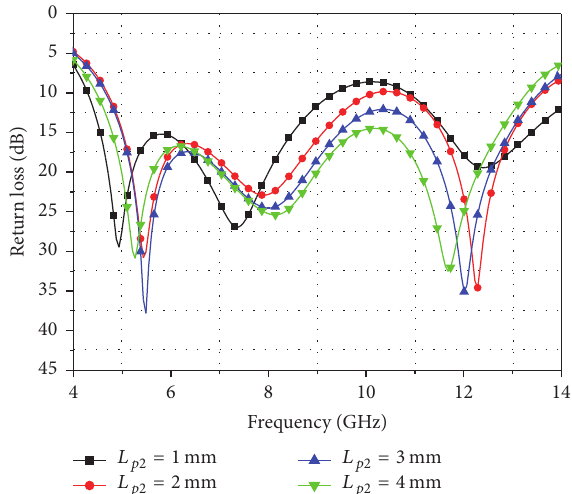
Figure 7: Simulated return loss against frequency for the proposed defectedsubstratewidebandantennawithvarious 𝐿 𝑝2 ;otherparam- eters are the same as listed in Table 1.